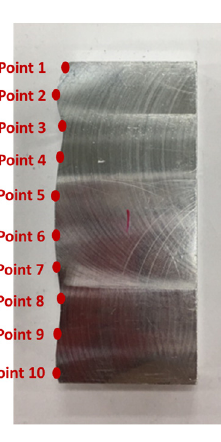
Figure 10. The finished part with curve mating. Table 2. The measured coordinates of the part.